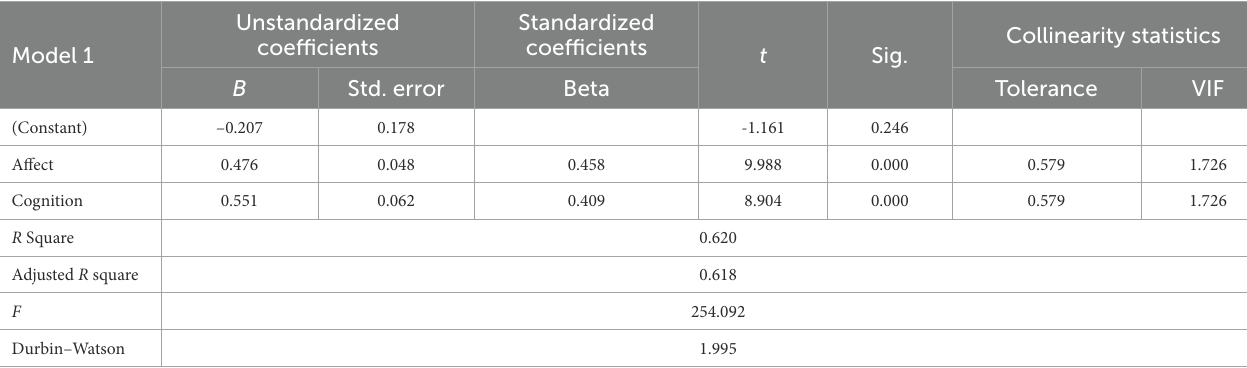
TABLE 5 Regression analysis of cognition, affect and conation. a